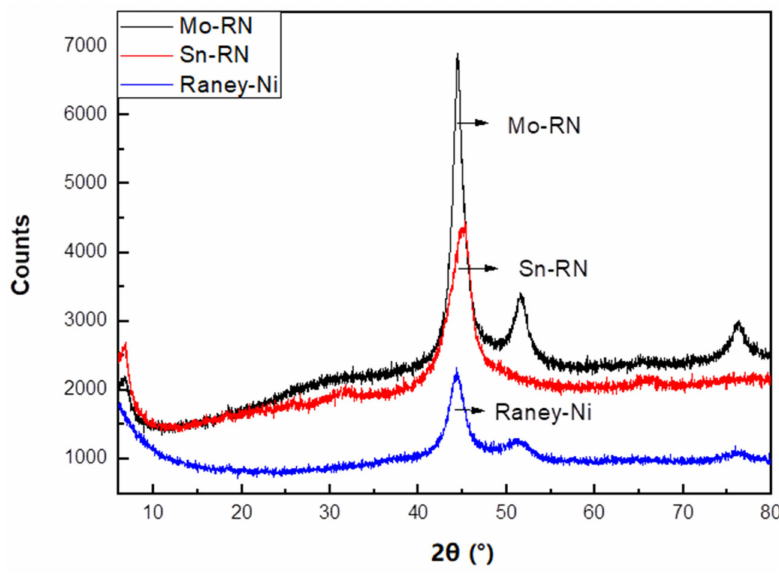
Figure 1. XRD patterns of Raney Ni catalyst and modified Raney Ni catalysts.